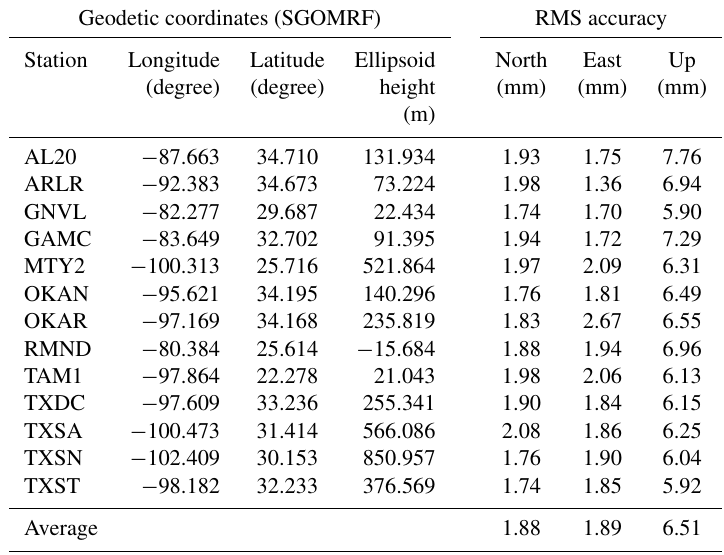
Table 2. Geodetic coordinates (longitude, latitude, ellipsoidal height) of the 13 reference sites with respect to SGOMRF and their RMS accuracy (repeatability). Geodetic coordinates (SGOMRF) RMS accuracy Station Longitude Latitude Ellipsoid